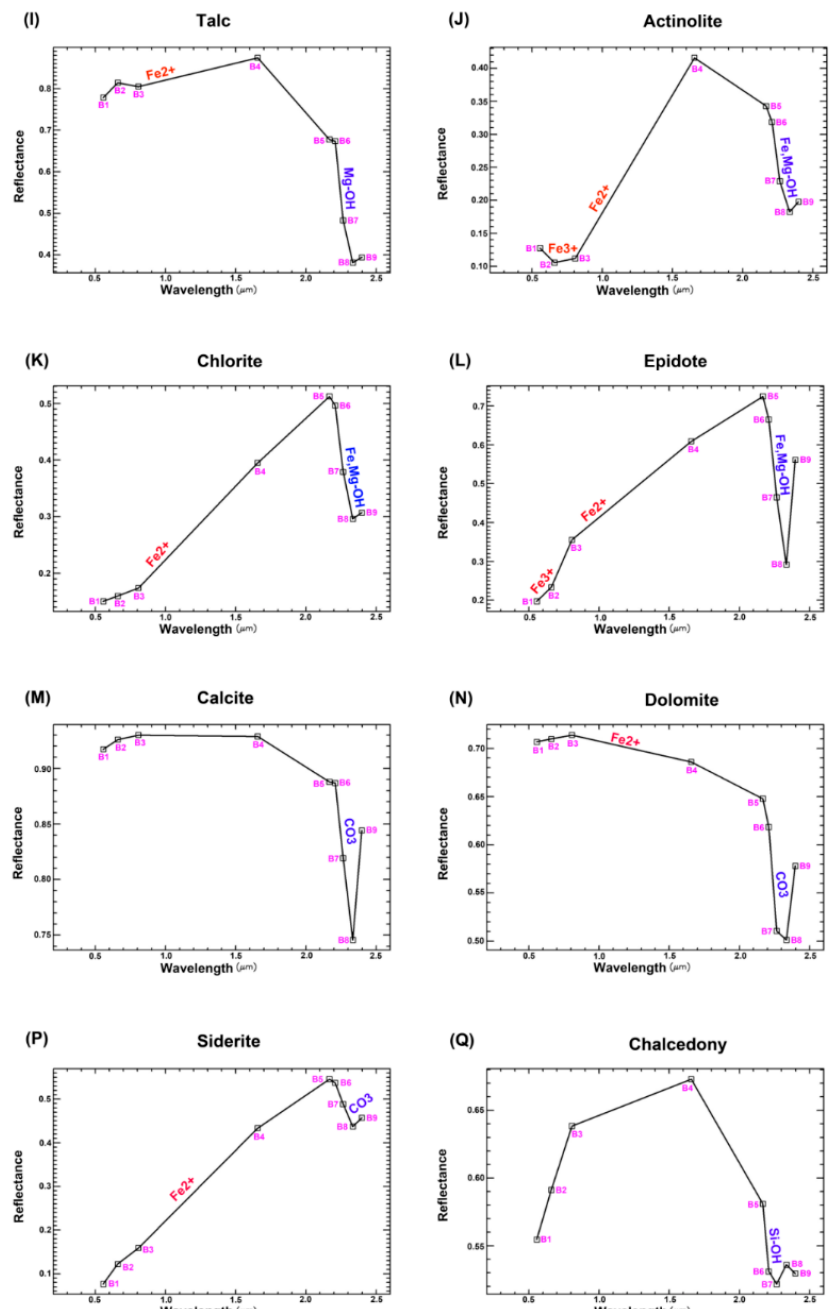
Figure 5. Laboratory reflectance spectra of the selected alteration minerals resampled to response functions of ASTER VINR + SWIR bands [117]. Cubes show the location of the ASTER VINR + SWIR bands (B1 to B9) from 0.50 µ m to 2.5 µ m. ( A ) goethite; ( B ) hematite; ( C ) jarosite; ( D ) biotite; ( E ) kaolinite; ( F ) muscovite; ( G ) antigorite; ( H) serpentine; ( I ) talc; ( J ) actinolite; ( K ) chlorite; ( L ) epidote; ( M ) calcite; ( N ) dolomite; ( P ) siderite; and ( Q ) chalcedony.